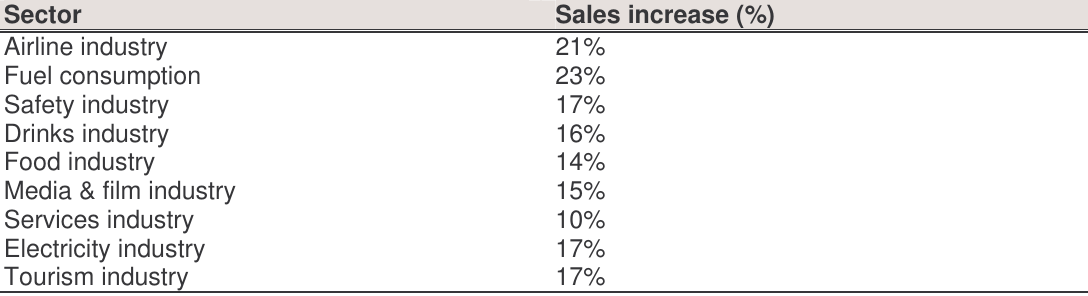
Table 2: Estimated increase in sales in various sectors Sector Sales increase (%) Airline industry 21% Fuel consumption 23% Safety industry 17%